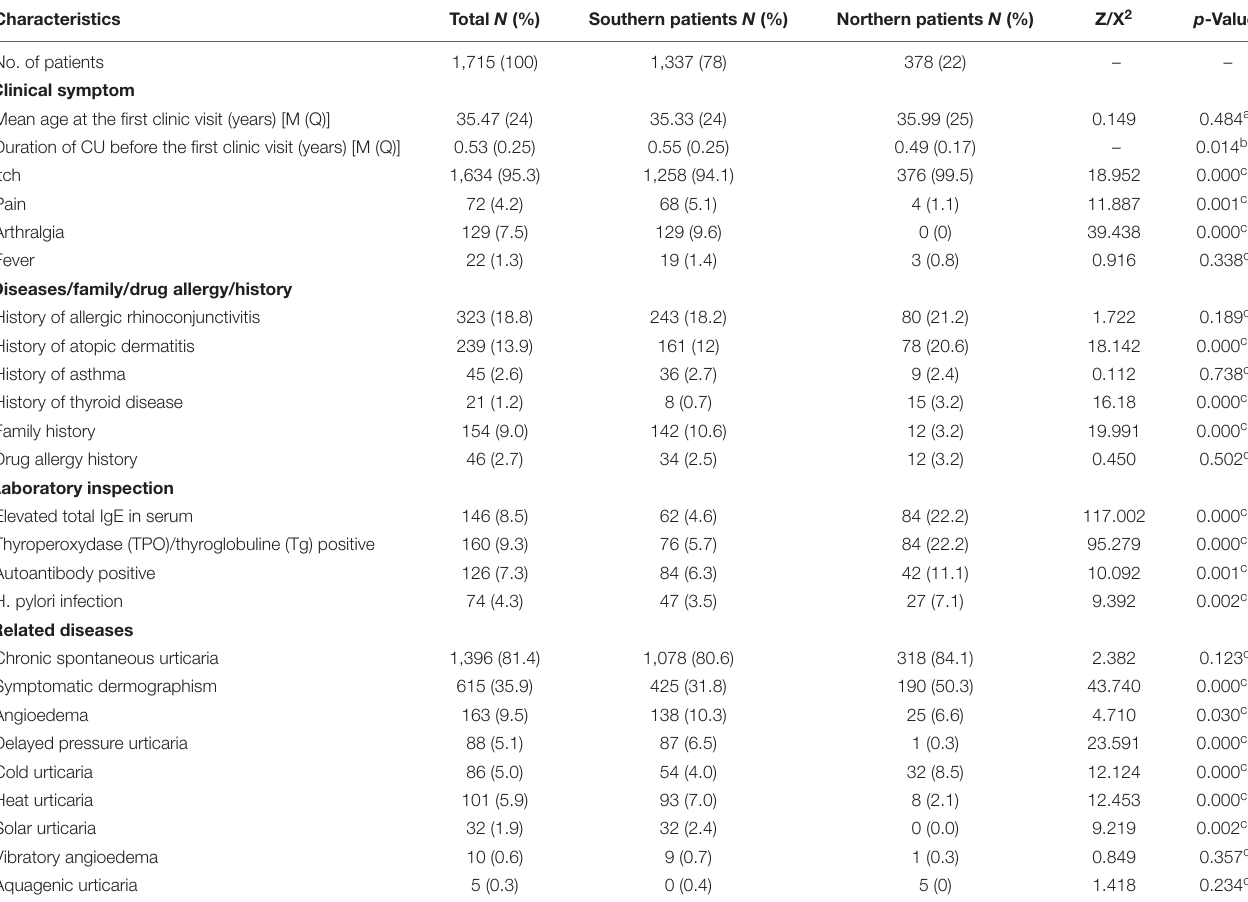
TABLE 2 | Clinical characteristics of each type of urticaria in different regions.